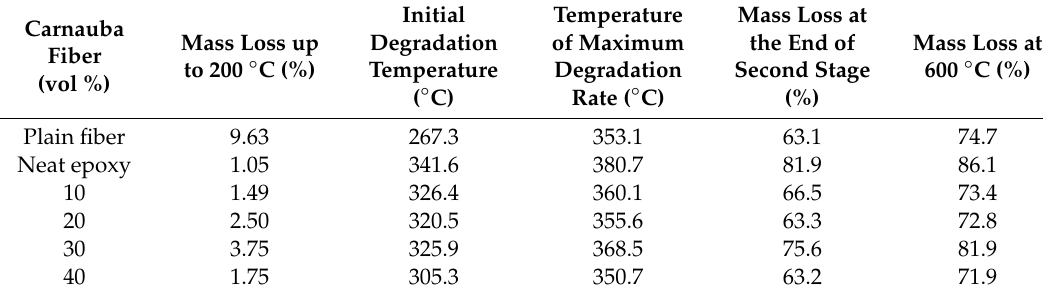
Table 6. Thermogravimetric parameters for the neat epoxy, plain fiber, and carnauba fiber composites.